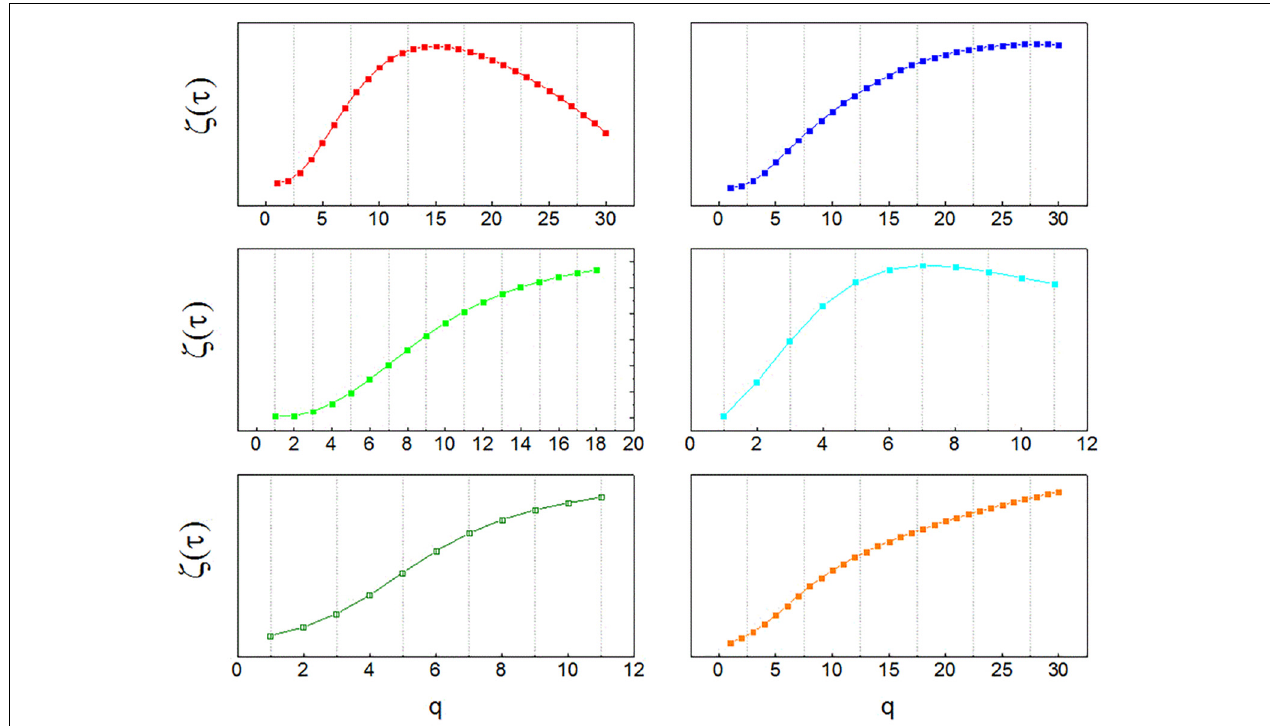
FIGURE 1 | Multifractal spectra of human neurons. Temporal multifractal spectra of sample neuronal recordings, obtained from the globus pallidus interna (GPi) of patients with Parkinson’s disease with the structure function method. The non-linearity of ζ τ (q) indicates multifractality. The function ζ τ (q) is calculated from temporal structure functions of increasing order q, S q ( τ ). Since structure functions are built from time series of neuronal activity, the spectra indicate multifractal organization in the temporal domain.